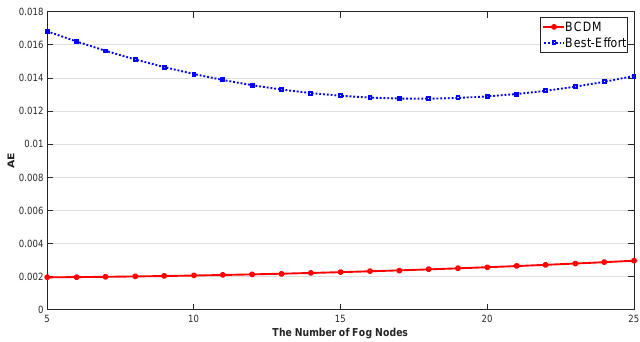
Figure 12. The Impact of the Number of Fog Nodes to Average Energy Consumption.